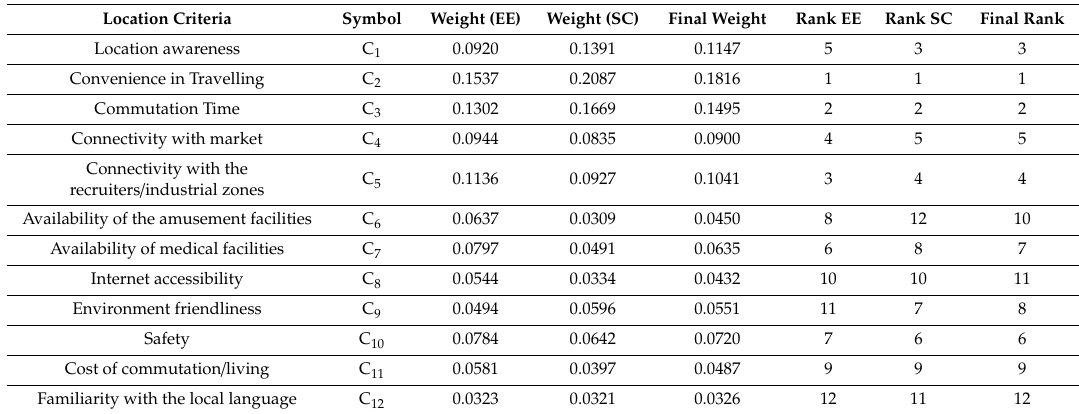
Table 17. Aggregate rank (SC and EE panel).